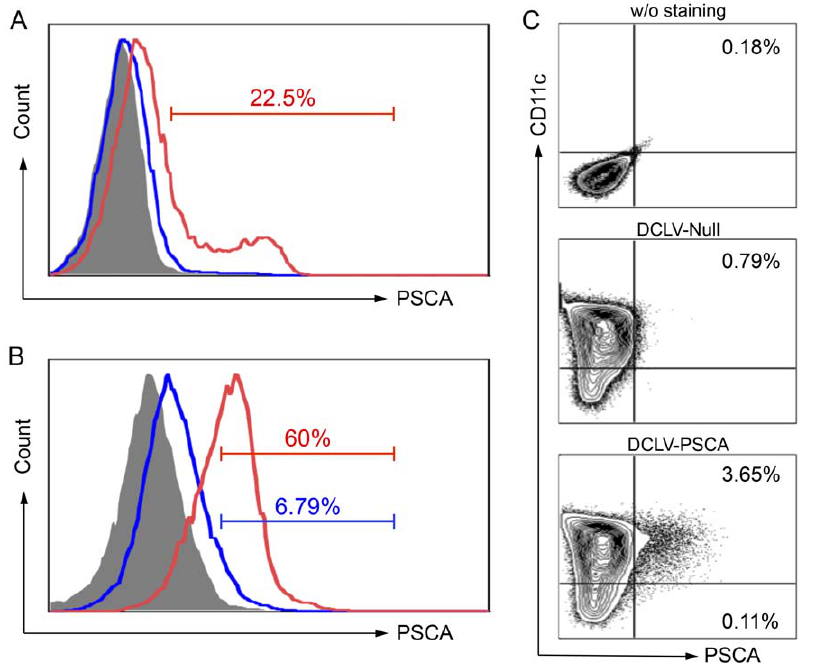
Figure 1. Targeted transduction and delivery of PSCA antigen gene into dendritic cells (DCs) by DCLV-PSCA. (A) 293T cells were transfected transiently with plasmids FUW-Null (mock control, blue line) or FUW-PSCA (red line). Two days later, cells were collected and stained for PSCA expression analyzed by flow cytometry. 293T cells stained with the isotype antibody were included as a control (grey shade area). (B) 293T cells were transfected transiently with plasmids FUW-PSCA, SVGmu, and other necessary lentiviral packaging plasmids to produce DCLV-PSCA vectors. Fresh virus supernatant was used to transduce 293T cells (blue line) or 293T.hDC-SIGN cells (red line) with MOI=10. PSCA expression was analyzed by flow cytometry 3 days post-transduction. (C) Bone marrow-derived DCs were transduced with a mock vector DC-LV-Null or DC-LV-PSCA vector. Five days later, CD11c and PSCA expression were assessed by flow cytometric analysis. All experiments were repeated three times and the representative data is